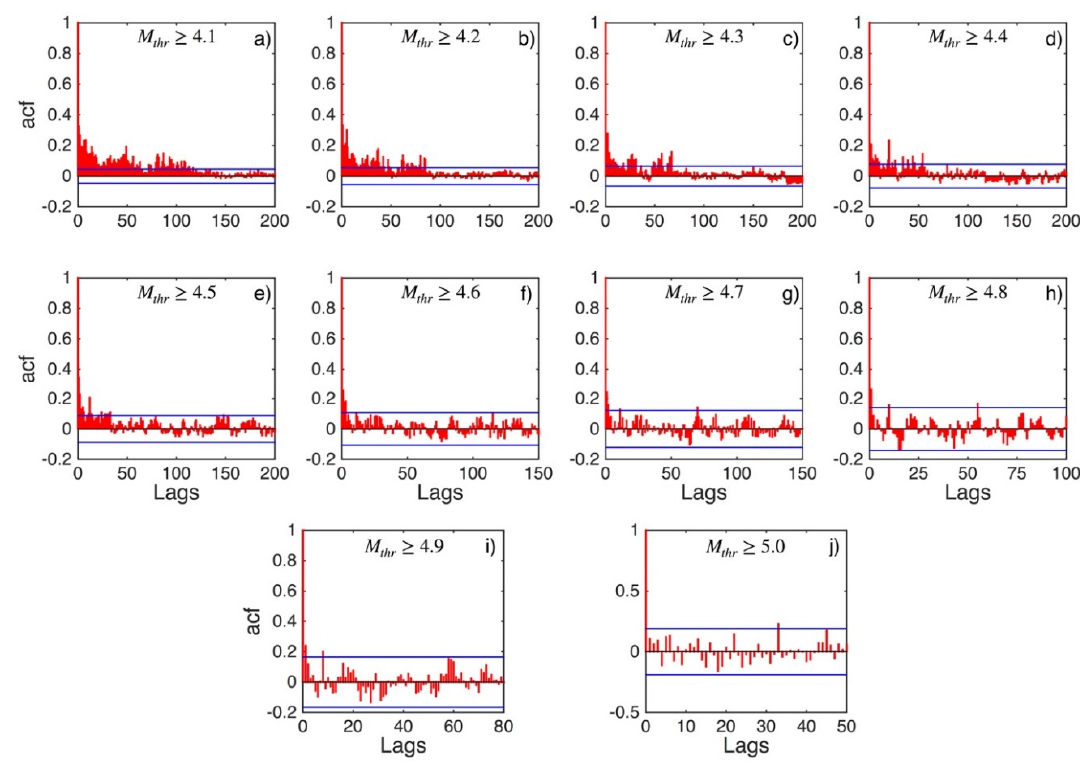
Figure A22. ACF values (red stems) and their 95% confidence intervals (blue lines) for North Aegean Sea (sub-area 9) for magnitude thresholds ( M thr ) varying from 4.1 to 5.0 (subplots a – j ).